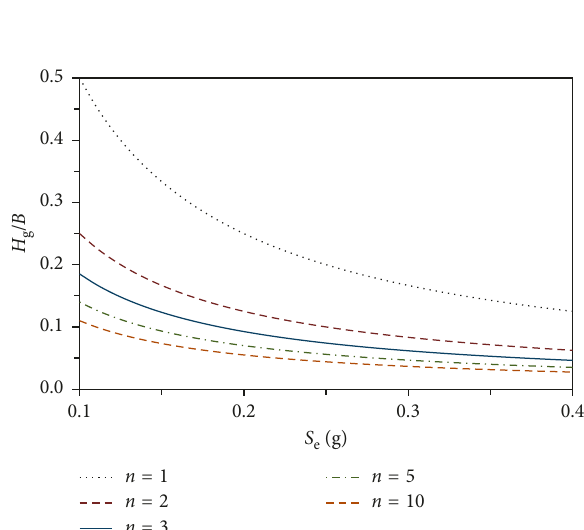
Figure 9: Plane frame with n